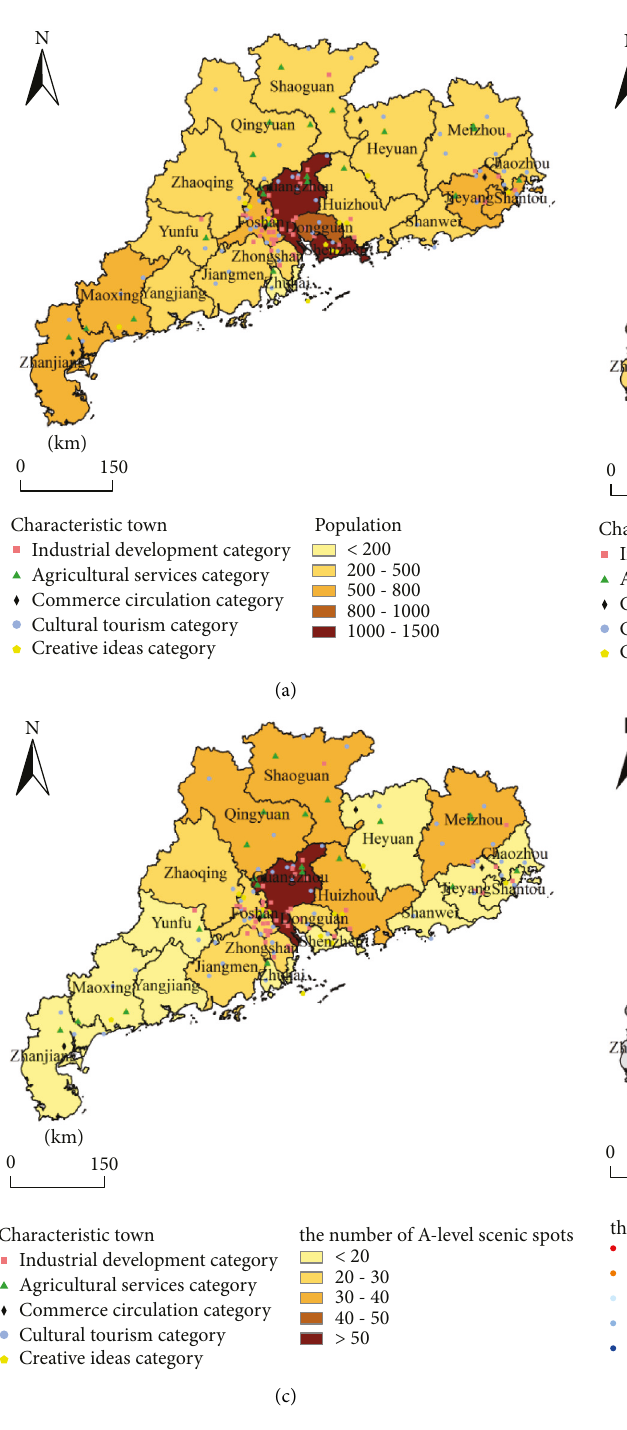
Figure 6: Analysis of influencing factors on the spatial distribution of Characteristic Towns in Guangdong Province (a) Population factors; (b) Economic factors; (c) Resource factors; (d) Location